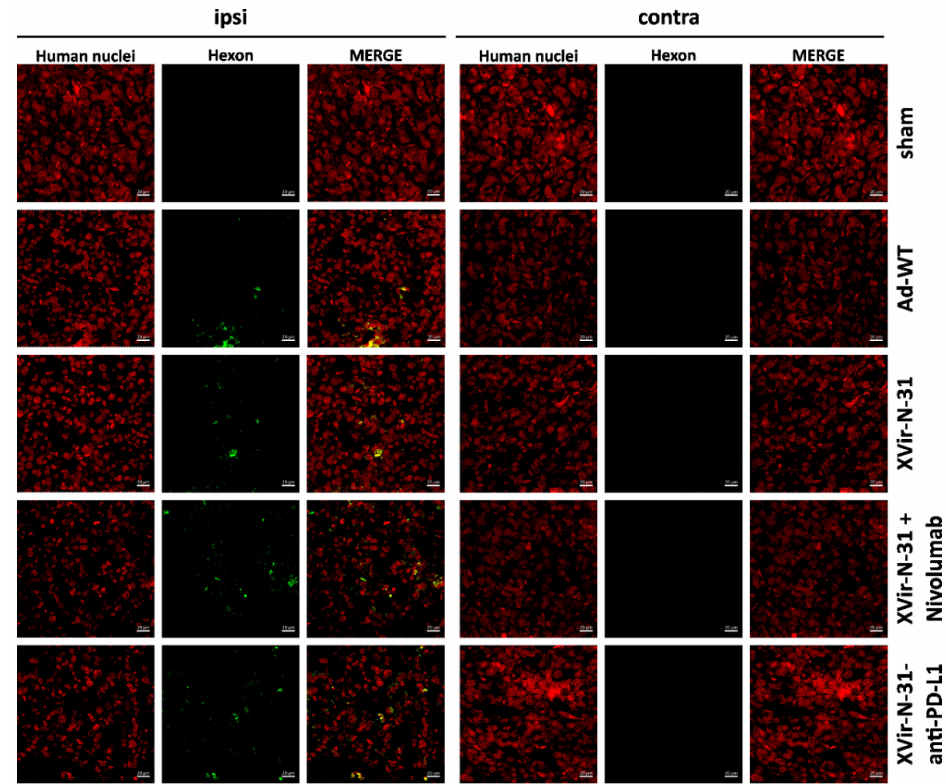
Figure 4. Hexon staining of ipsilateral injected and contralateral non-treated tumors. The detection of the adenoviral hexon protein (green) in the U87MG ipsilateral virus-injected and contralateral tumors (identified by staining for human nuclei, red) 35 days after intratumoral injection of either PBS (sham), 3 × 10 8 IFU of either Ad-WT, of XVir-N-31 alone or in combination with multiple systemic applications of nivolumab, or of XVir-N-31-anti-PD-L1 (n = 7–8 mice per group; representative pictures are